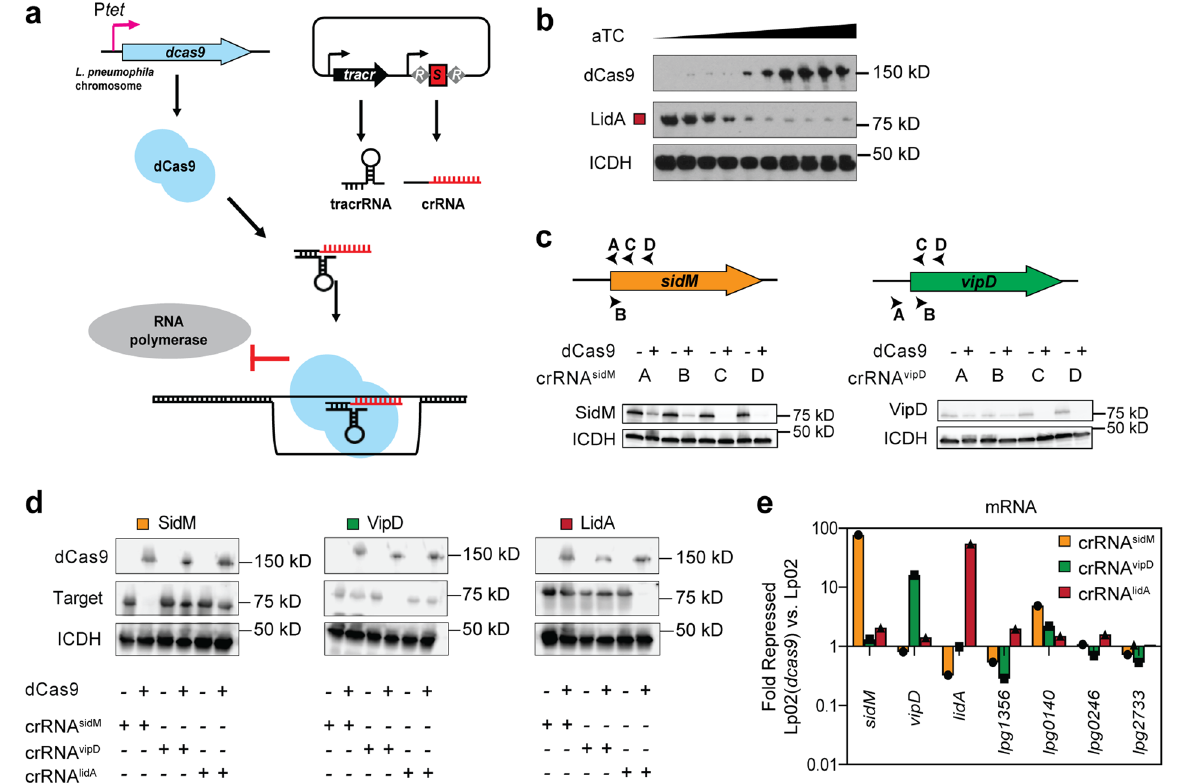
Fig. 1 CRISPRi is adaptable to L. pneumophila. a Schematic of the L. pneumophila single-plex CRISPRi platform. Chromosome-encoded dCas9 and plasmid- expressed tracrRNA and crRNA assemble into a CRISPRi complex. The crRNA directs the complex to the target gene through base pairing. Gene expression is repressed through sterically precluding RNA polymerase. R indicates repeats and S indicates spacers of the crRNA-encoding repeat/spacer array. b Immunoblot analysis showing the protein level of dCas9 in response to aTC-dependent induction of P tet - dcas9 , leading to decreased protein levels of the crRNA lidA target. Isocitrate dehydrogenase (ICDH) serves as a loading control. aTC concentrations are 0, 0.15, 0.3, 0.63, 1.23, 2.5, 5, 10, 20, and 80 ng/mL. c Immunoblots reveal the ef fi ciency of target repression at different crRNA target sites (arrow heads A-D) for two genes, sidM and vipD ( + 40 ng/ mL aTC). ICDH serves as a loading control. d , e Strains expressing crRNA sidM (site C), crRNA vipD (site C), and crRNA lidA were surveyed for CRISPRi speci fi city at both the protein ( d ) and mRNA ( e ) level ( + 40 ng/mL aTC). ICDH serves as an immunoblot loading control. qPCR was used to measure mRNA levels of sidM, vipD, lidA and four randomly chosen control genes in Lp02( dcas9 ) and Lp02 strains. Fold repression was determined using ΔΔ C T . A value of 1 indicates that the gene level was the same in the Lp02( dcas9 ) and Lp02